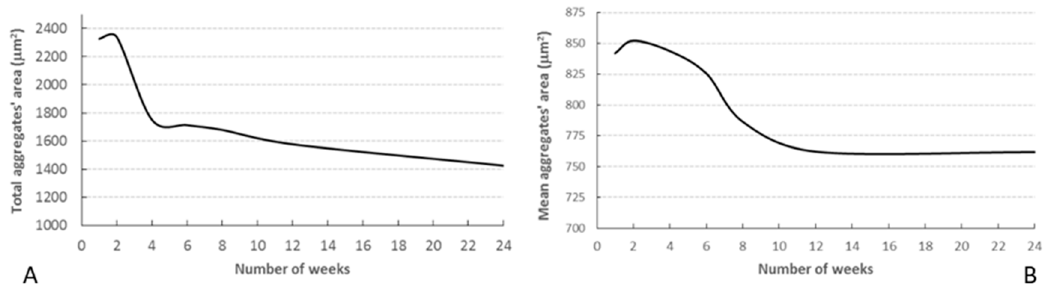
Figure 4. Temporal change in aggregate area. ( A ) Total area of the aggregates located in the vitreous; ( B ) mean area of the aggregates.